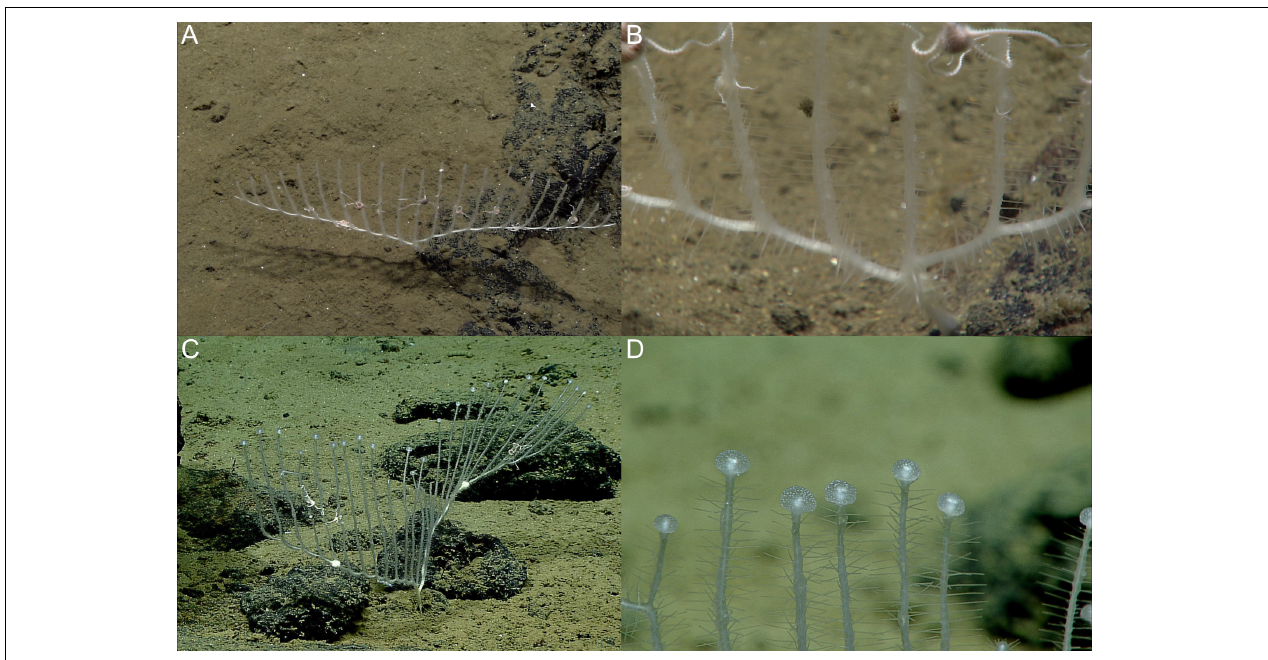
FIGURE 8 | Chondrocladia ( Symmetrocladia ) lyra in situ images from ROV feed. (A,B) Specimen USNM 1424083 and (C,D) specimen USNM 1424173.